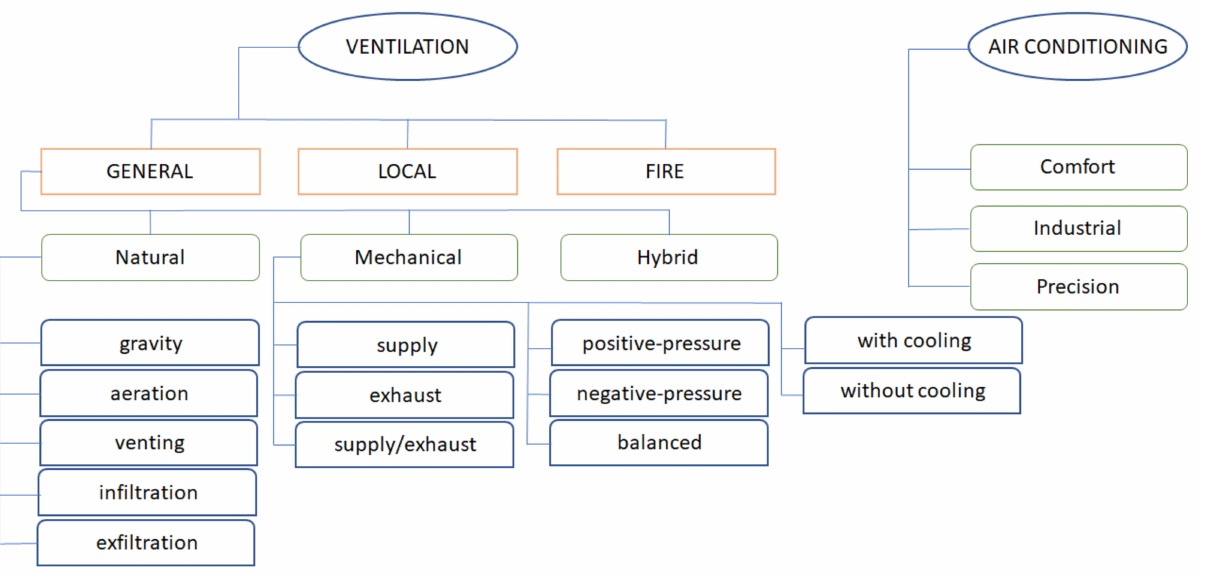
Figure 1. General division of ventilation and air-conditioning systems